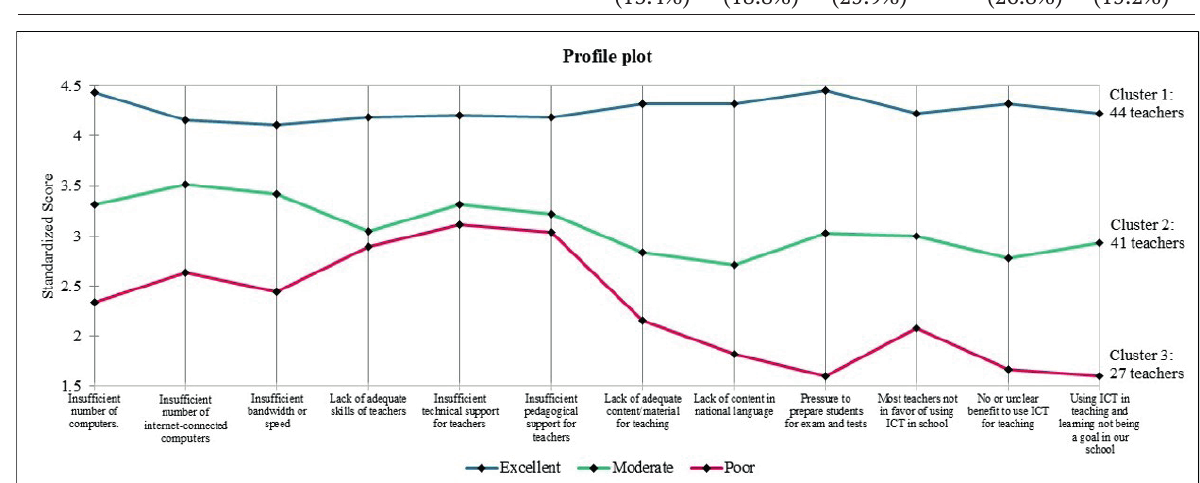
Figure 1. Groups profile plots of different clusters of the relative perceived barriers of the PE teachers conducted for further analysis. The DA was applied to variables. Standard, backward stepwise, and clusters defined by HACA to look through variation in relative barriers to technology usage. The clusters act as the dependent variable, whereas perceived barriers parameters were treated as independent